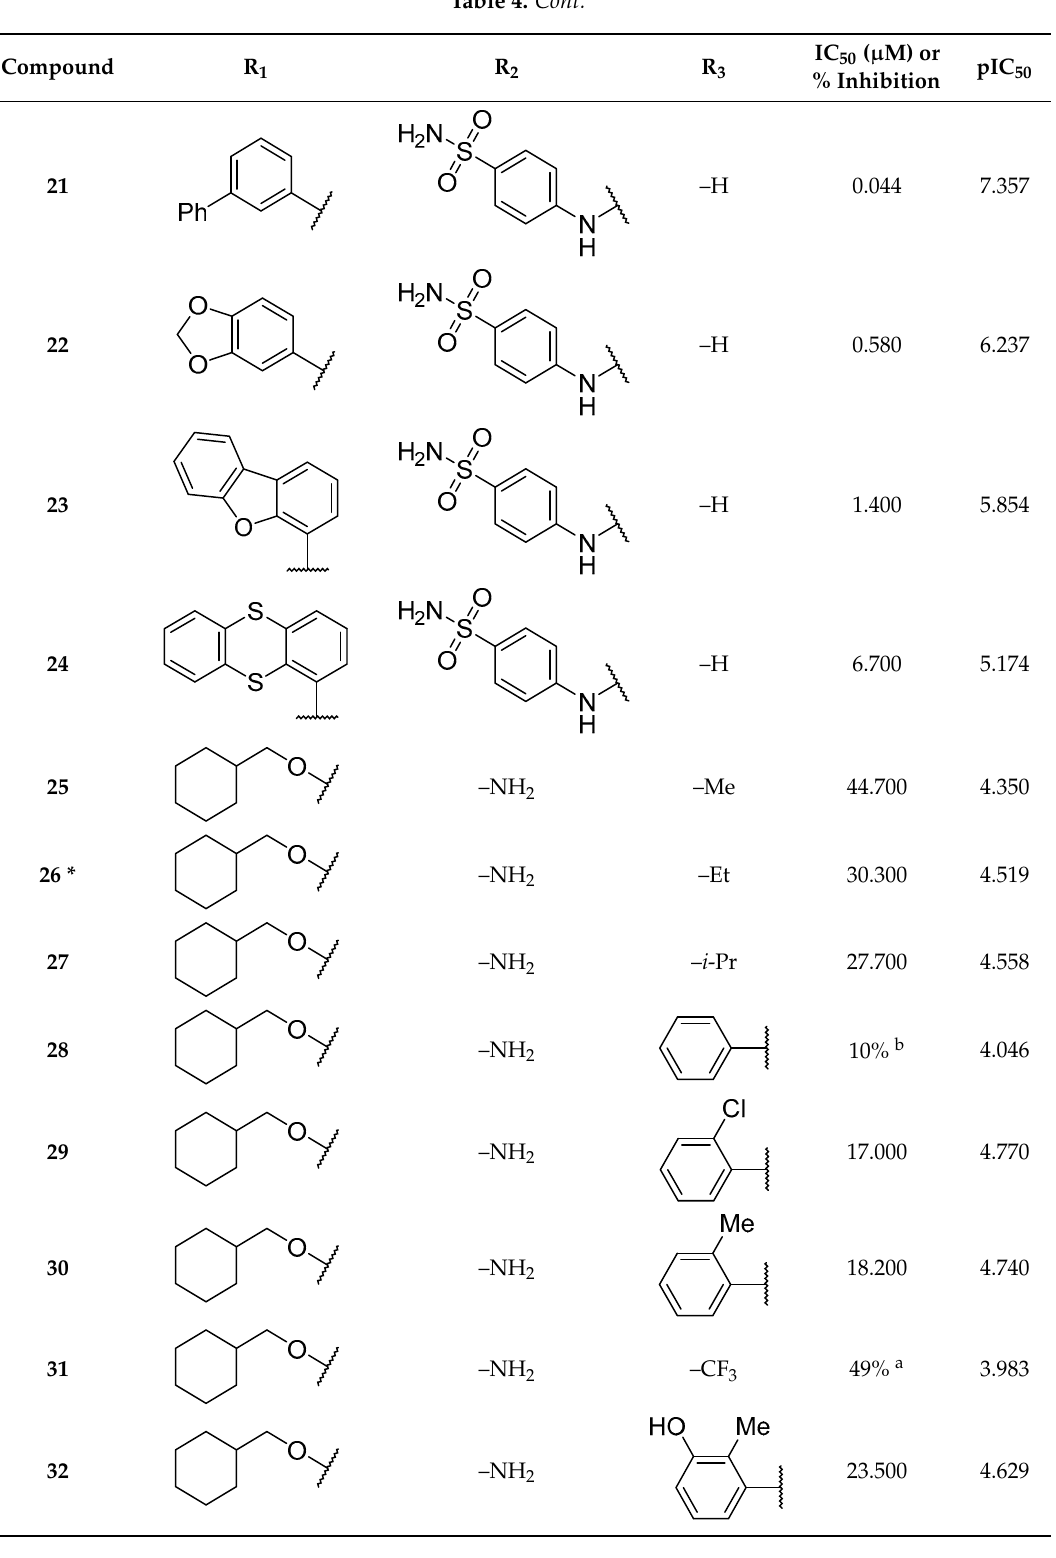
Table 4. The structures and the pIC 50 values of the dataset compounds.